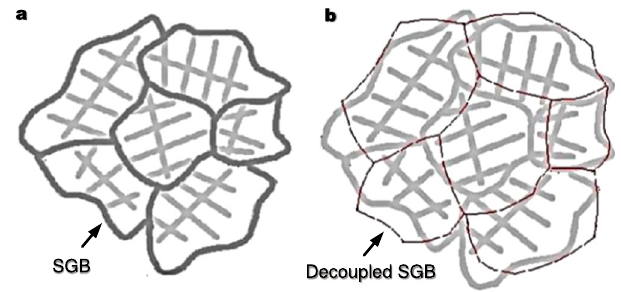
Fig. 1 | Schematic correspondence between dendrite cells of different orien- tations and solidi fi cation grain boundaries (SGBs). a Typical correspondence. b Decoupled SGBs due to